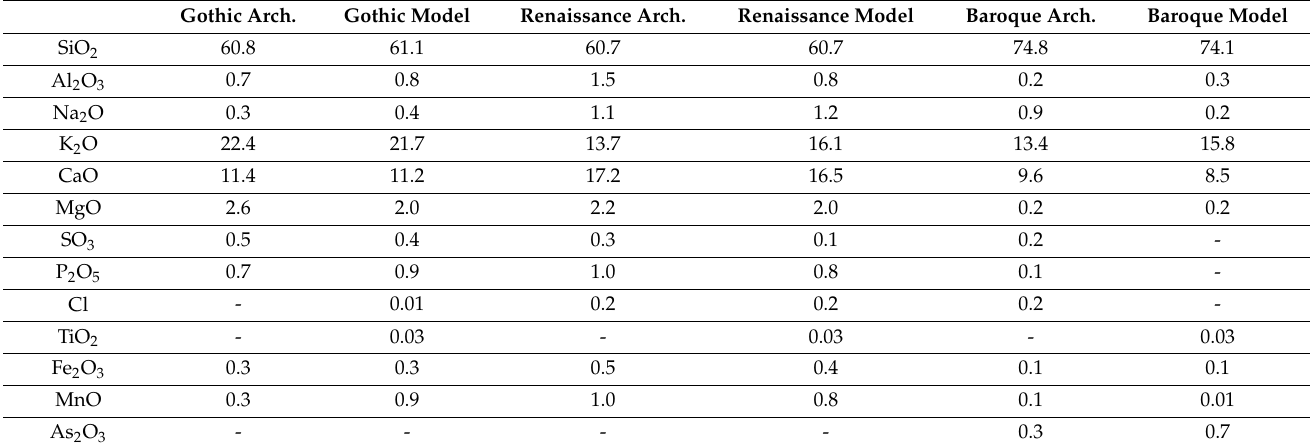
Table 2. Chemical composition of model and archaeological glasses [wt.%] [1]. Gothic